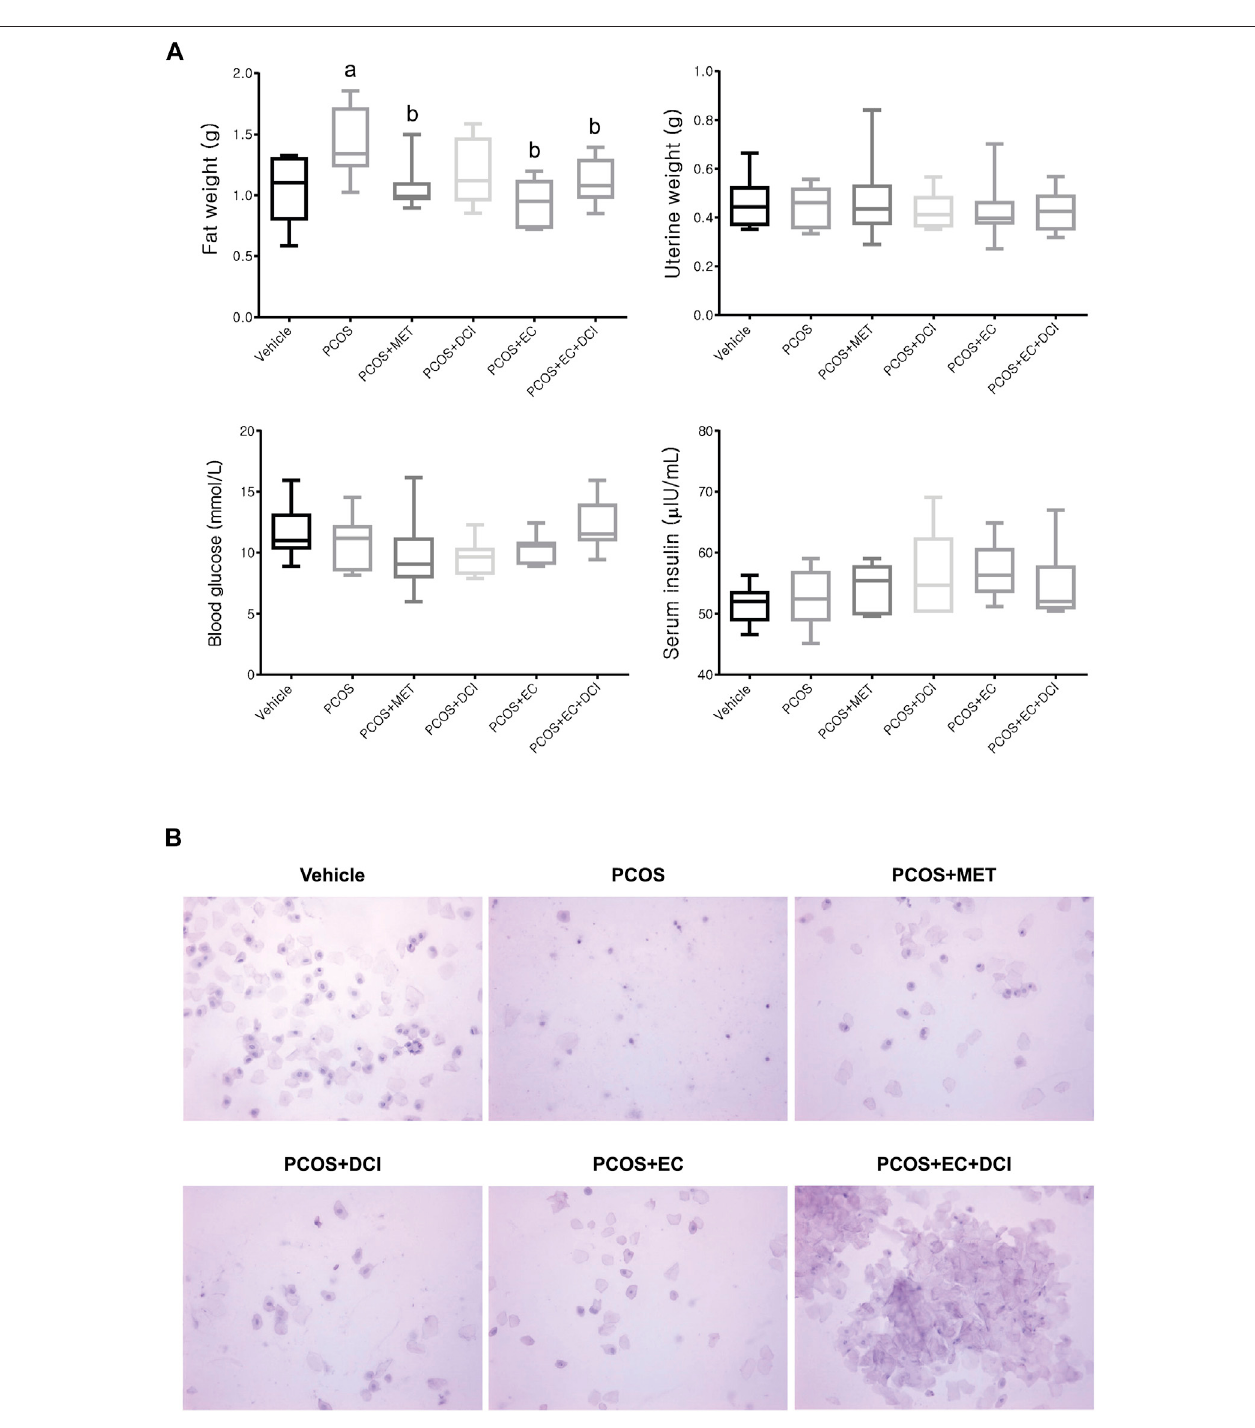
FIGURE 3 | Effect of EC extract DCI on physiological changes. (A) The retroperitoneal posterior fat weight, uterine weight, the levels of blood glucose, and serum insulinweremeasuredattheendoftheexperiment. (B) Thepicture(s)ofvaginalsmearperformedattheendofexperiment(×200).MET,metformin;EC, Eckloniacava K.; DCI, d-chiro